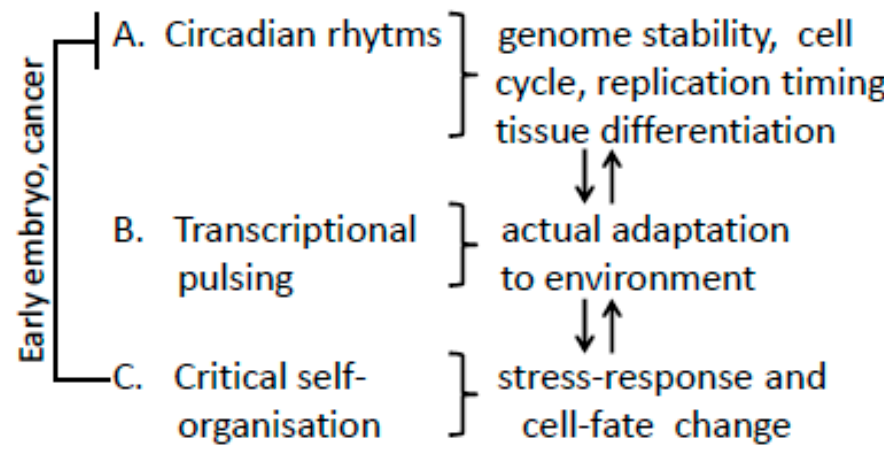
Figure 4. A scheme of three time–space-related regulation modes of cell functions. ( A ) By circadian 24 h clock—a molecular oscillator sub-driving the regulation of the cell cycle (pace and checkpoints) and replication timing, which is setting the epigenetic (tissue-specific) chromatin compartments. In general, this oscillator cares for the genome stability and its robust functions. ( B ) Transcription pulsing (bursting), whose frequency is determined by tissue-specificity but volume of individual gene transcripts, is adapting by feedback to environment demands. A special type of transcriptional pulsing—the immediate stress response—is a prerequisite of transition from the small fluctuations supporting functional homeostasis to ( C ) critical self-organization of the whole genome, which is occurring very rapidly, using a bistable phase transition and changing cell fate. This type of regulation is observed in an early embryo, embryonic stem cells, and in cancer (related to polyploidy) and acts along with deterioration of circadian clock.